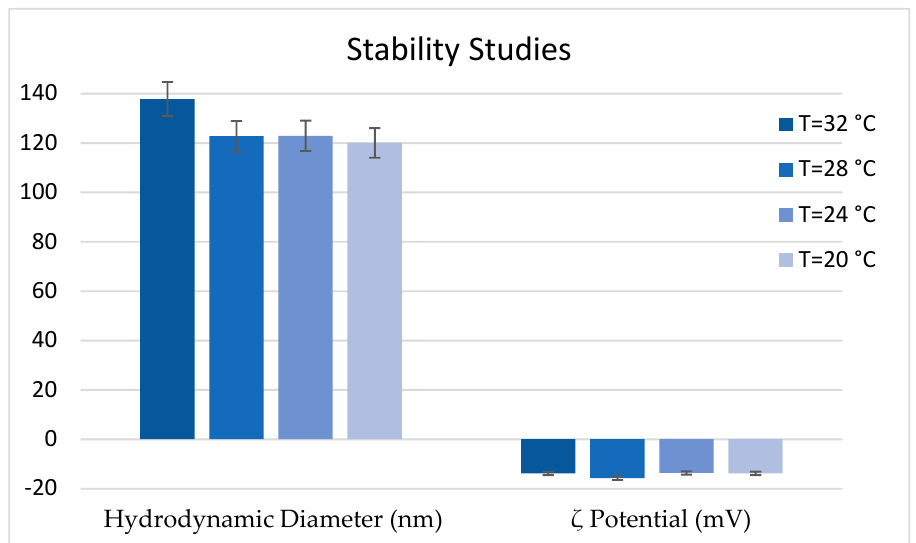
Figure 4. Sample 21 (post-sonication) stability in terms of hydrodynamic diameter and ζ -potential from 32 °C to 20 °C.